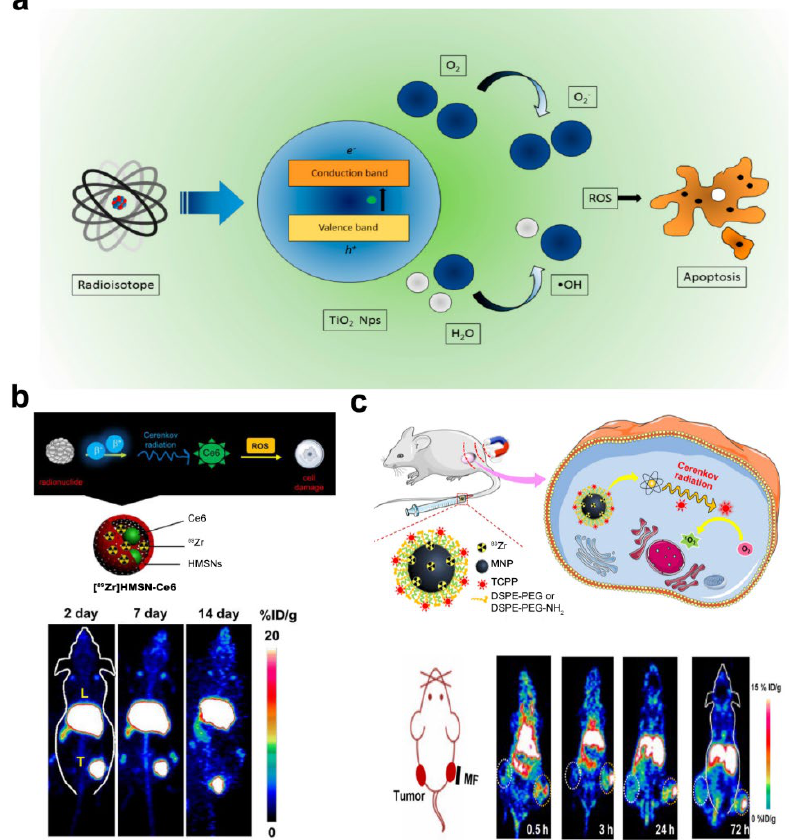
Figure 5. Schematic illustration for Cherenkov luminescence (CL) photodynamic therapy (PDT) and its effects. ( a ) Principle of PDT based on CL in TiO 2 nanoparticles. Adapted with permission from Ref. [144] 2020 MDPI. ( b ) Top: Diagrams of 89 Zr HMSN-Ce6 structure. Bottom: Maximum intensity projection positron emission tomography (PET) images of 4T1 tumor-bearing mice taken at various time points post injection of 89 Zr HMSN-Ce6. Adapted with permission from Ref. [52] 2016 American Chemical Society. ( c ) Top: Diagrams of magnetism-enhanced CL induced PDT. Bottom: representative coronal PET imaging slices of bilateral 4T1 tumor-bearing mice after the intravenous injection of 89 Zr-MNP-PEG at different time points. Adapted with permission from Ref. [130] 2018 American Chemical Society. NPs: nanoparticles; ROS: reactive oxygen species; HMSN: hollow mesoporous silica nanoparticle; MNP: magnetic nanoparticle; MF: magnetic